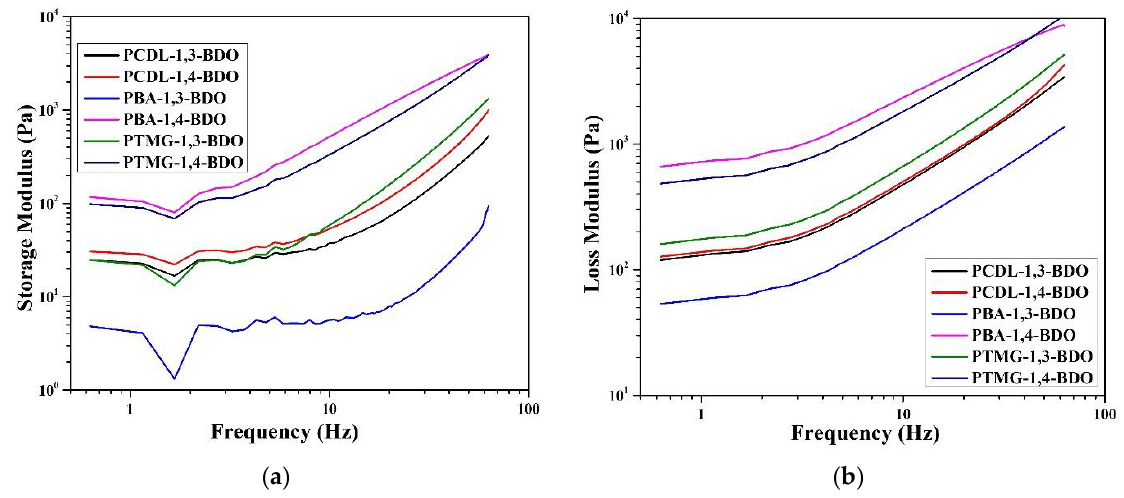
Figure 8. Rheological properties. ( a ) Storage modulus and ( b ) loss modulus of TPUs prepared using 1,3-BDO or 1,4-BDO during the synthesizing of PBA, PTMG, or PCDL.